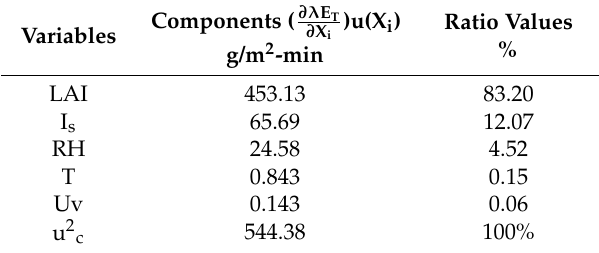
Table 4. The contribution of variable measurement to uncertainty for the Stanghellini ET s equation.